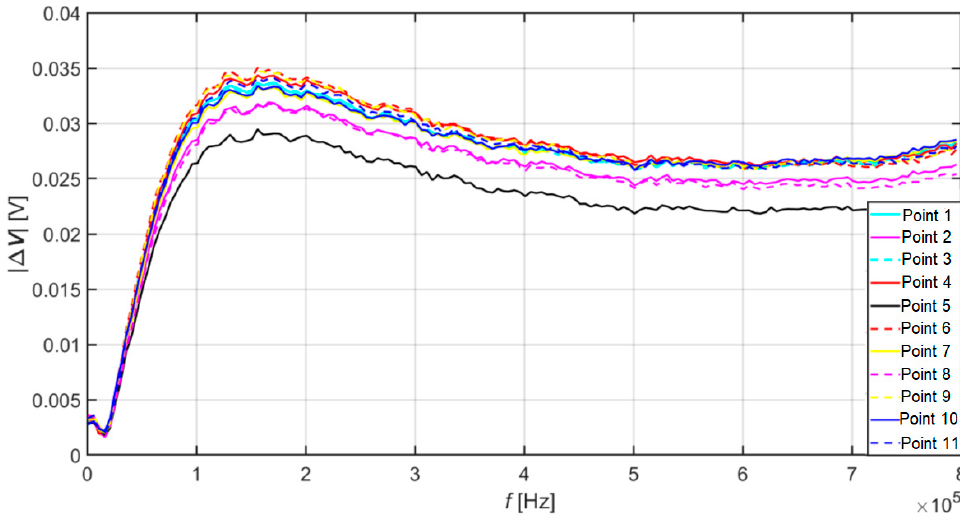
Figure 7. Graph of the absolute value of the voltage phasor of Specimen 3 corrosion crack.